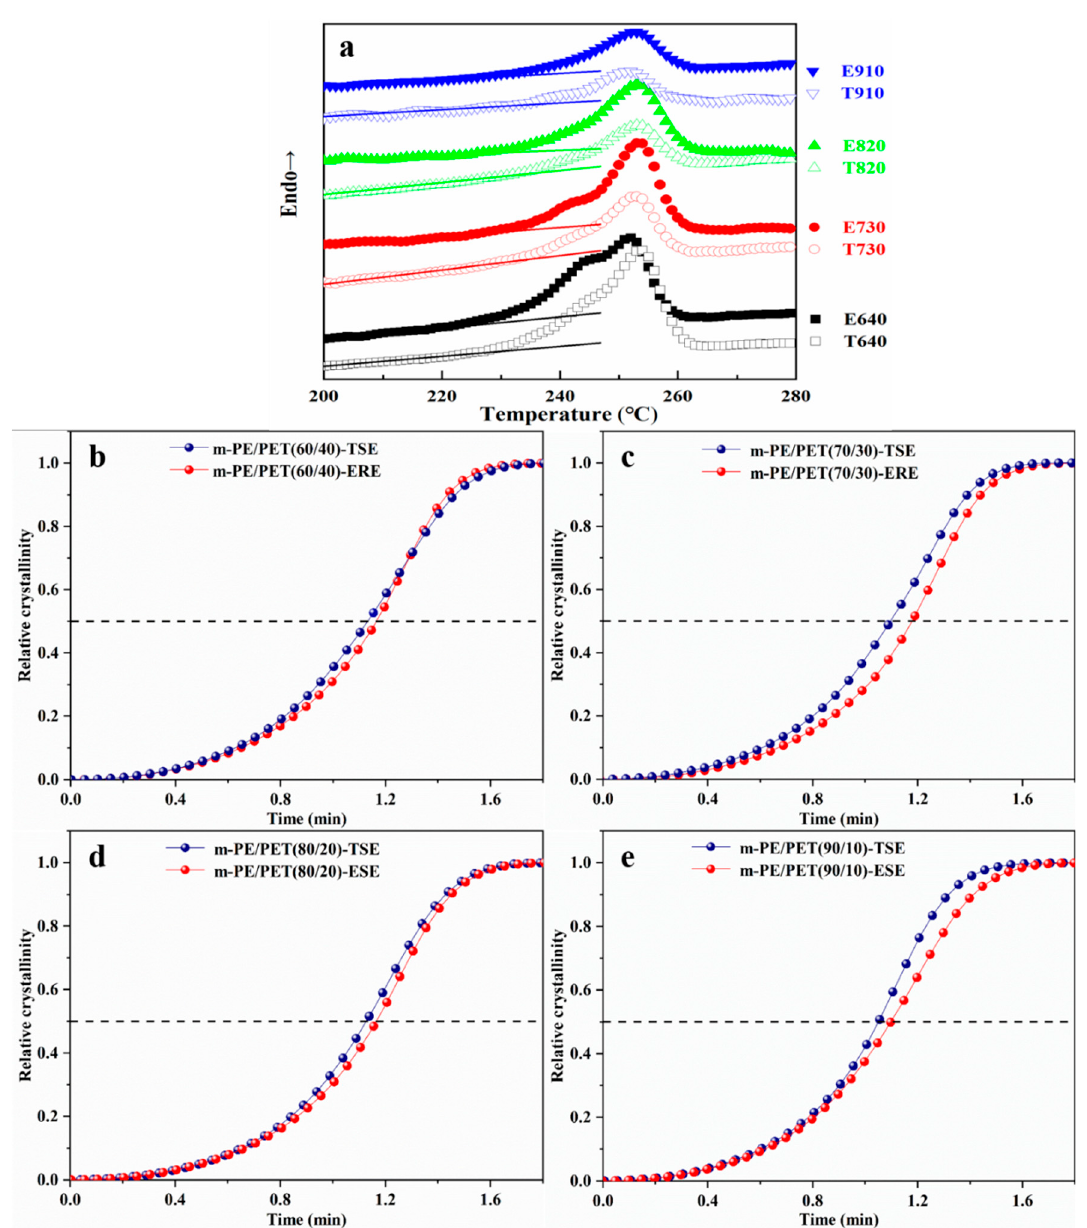
Figure 7. Second heating curve and the relative crystallinity of PET in m-PE/PET blends processed via ERE and TSE, respectively. ( a ) second-endothermic curves of the blends processed via ERE and TSE; ( b – e ) the relative crystallinity of the blends processed via ERE and TSE at different matrix ratio.